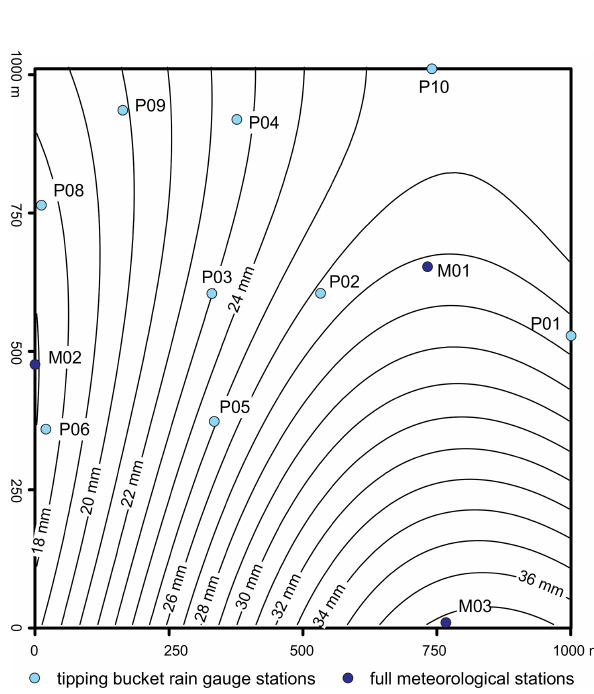
Figure 8. Geostatistically interpolated rain depth (mm) of an ero- sive event with a substantial rainfall gradient (event 116, 26 Au- gust 1996); average rain depth calculated from the geostatistical in- terpolation in 10m × 10m blocks was 23.6mm and average gradient in rain depth was 15.7mmkm − 1 . Figure adapted from Fiener and Auerswald